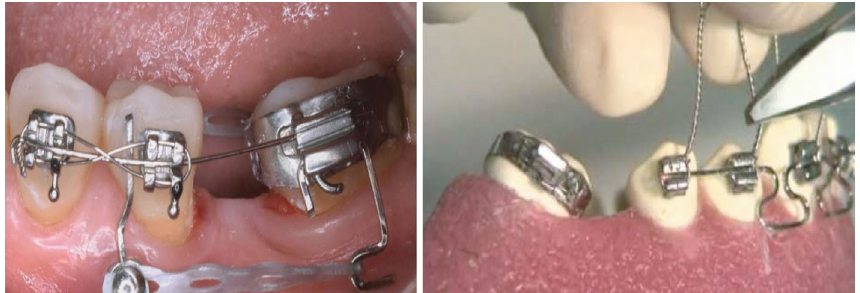
Figure 1: Contributions of orthodontics to better prosthetic treatments. Orthodontics verticalizes the position of the inclined teeth that will serve as pillars for the prosthesis, improving its support.